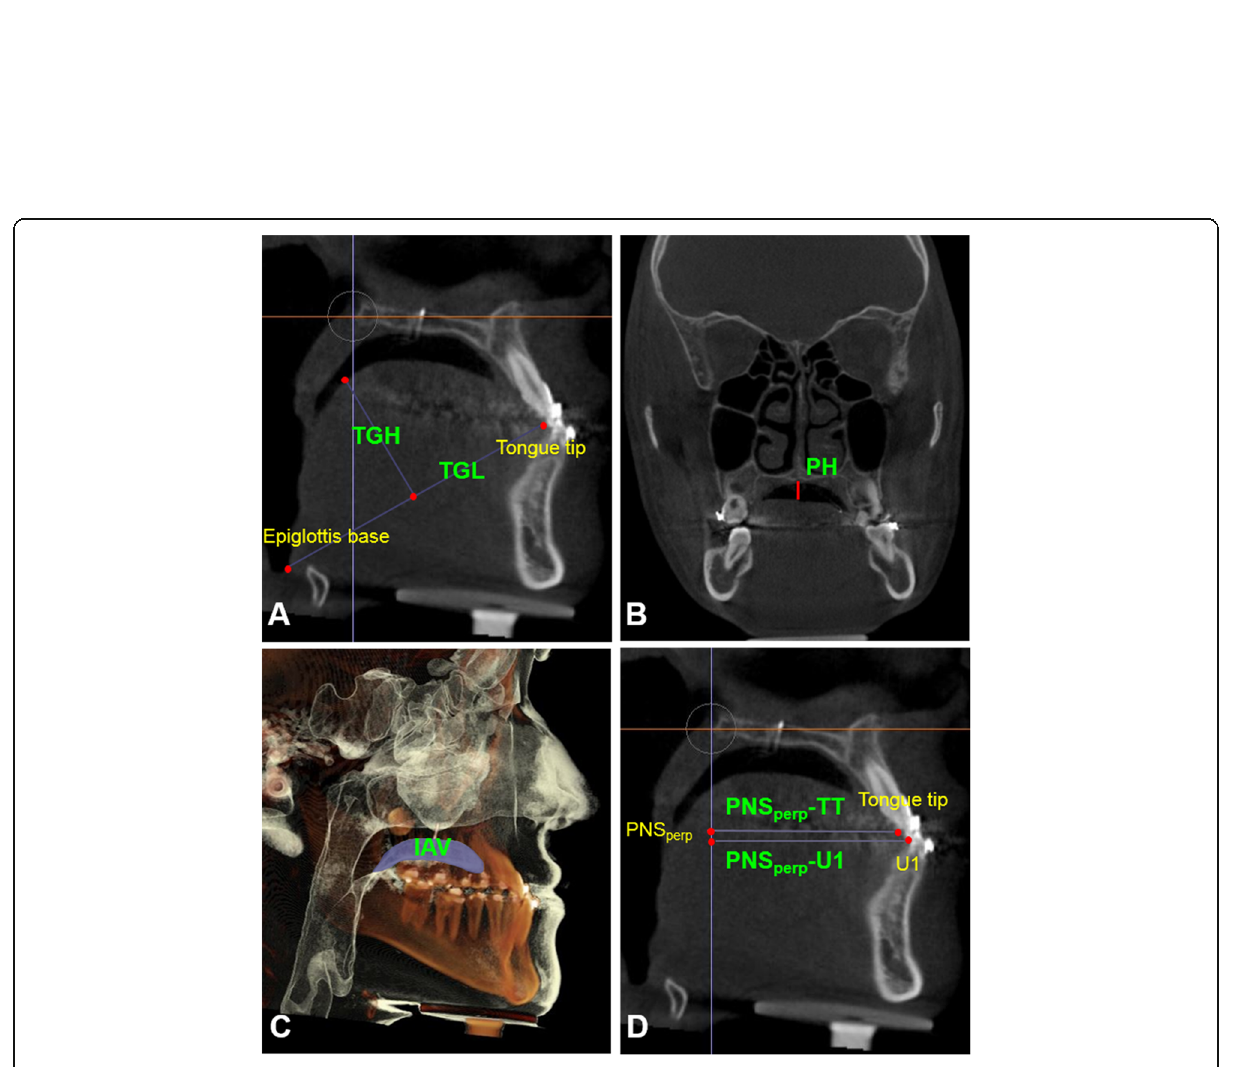
Fig. 2 Tongue dimensions and position measurements. a Tongue length (TGL) (mm), the distance from epiglottis base and tongue tip; tongue height (TGH) (mm), the length of the vertical bisector from the dorsal tongue surface to a line connecting between the epiglottis base and tongue tip. b Palatal height (PH) (mm), the distance between the tongue ’ s highest point and the palate in the coronal view. c Intraoral airway volume (IAV) (mm 3 ), the empty space between the tongue and palatal section. d PNS perp -TT/PNS perp -U1, the ratio of the distance from TT and U1 to a PNS perpendicular line to the FH